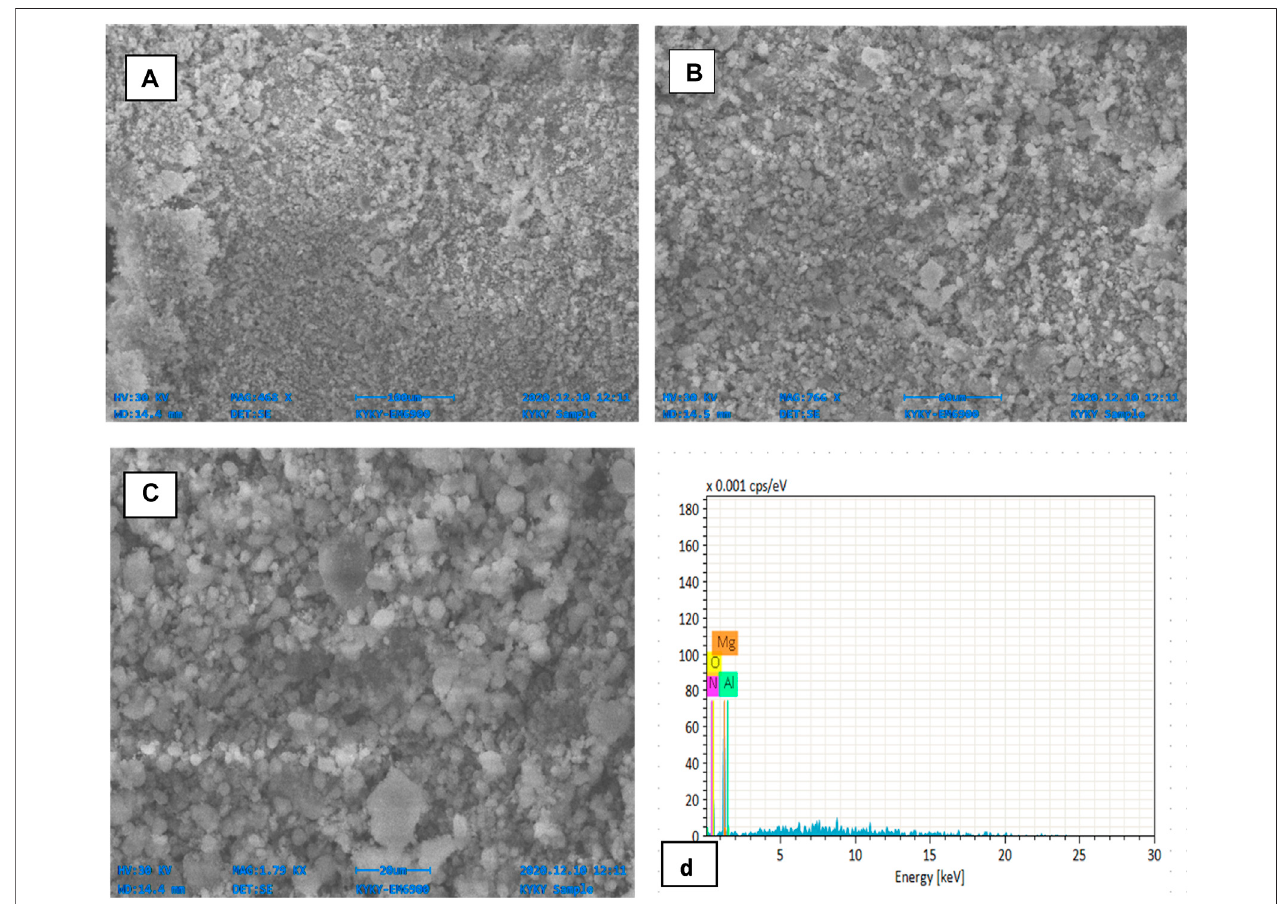
FIGURE 2 | SEM images of catalyst (A,B,C) , energy dispersive X-ray (EDX) spectrum of MgO (D) .